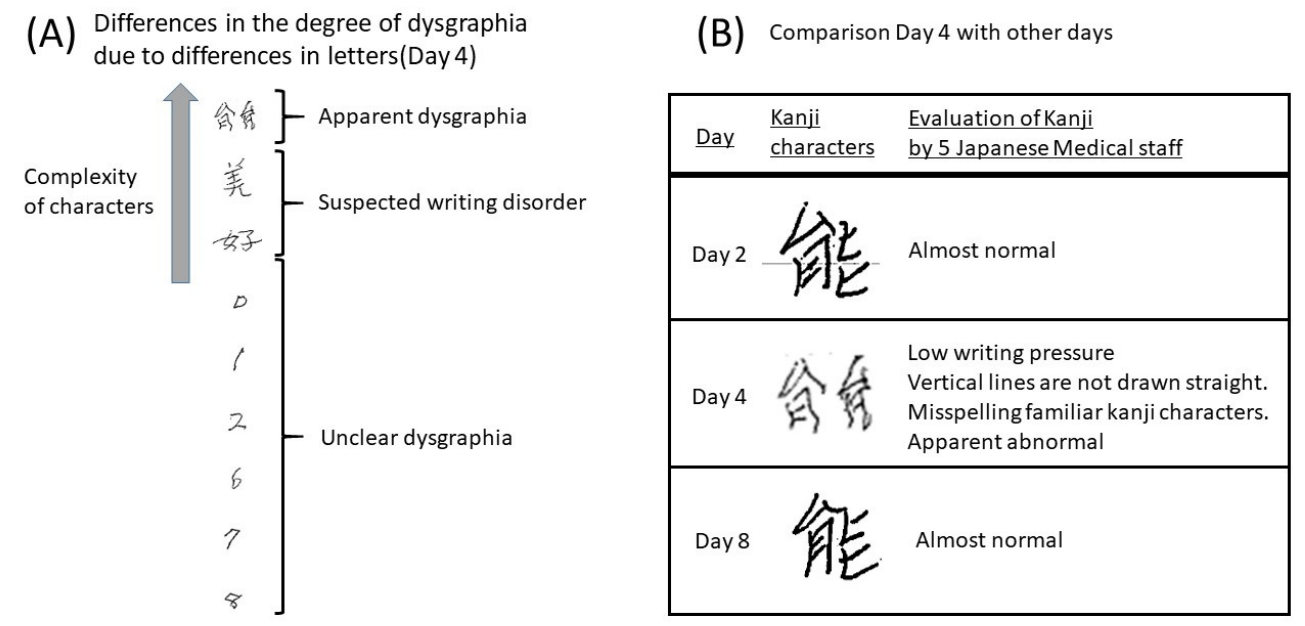
Figure 1. Characteristic changes in the patient's written characters (partially extracted). It was easier to identify changes in Kanji characters than those in numbers. One Japanese character has multiple meanings. For example, “Nou” is the power to do work, work, action, effect, efficacy, working, tech- nique, place name, etc. The character for "Bi" means fine or beautiful in appearance, excellent or good in content, or praiseworthy. The character for “Yoshi“ means loving, preferring, beautiful, good looking, good, just right. Combinations of several letters indicate a particular meaning. For example, combining “Bi” with “Kei”, meaning "shape," means especially good looking.